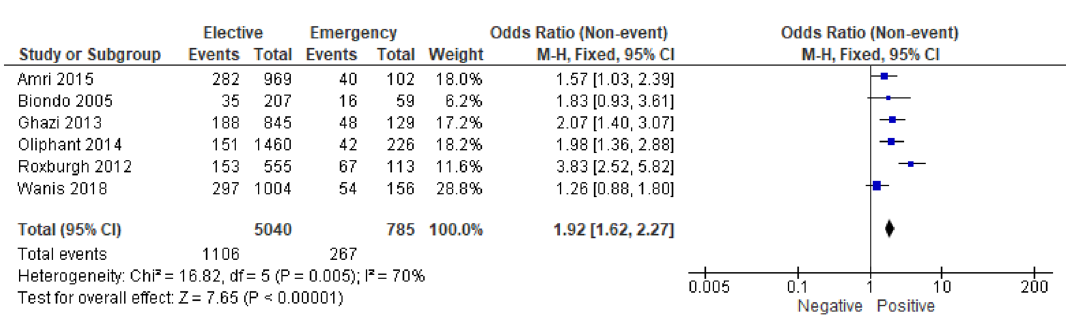
Figure 8. Association between presence of lymphovascular invasion and emergency presentation—Forest Plot.